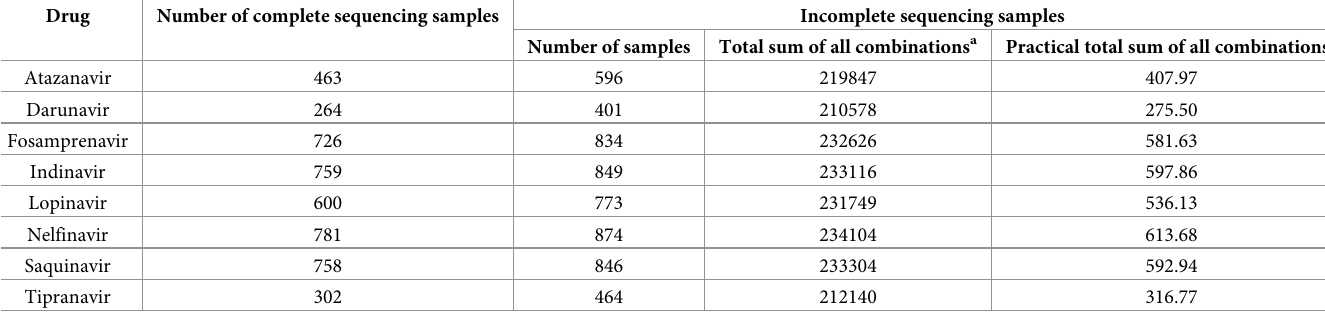
Table 1. Numbers of sequencing samples listed in the database for each HIV-1 protease inhibitor. Drug